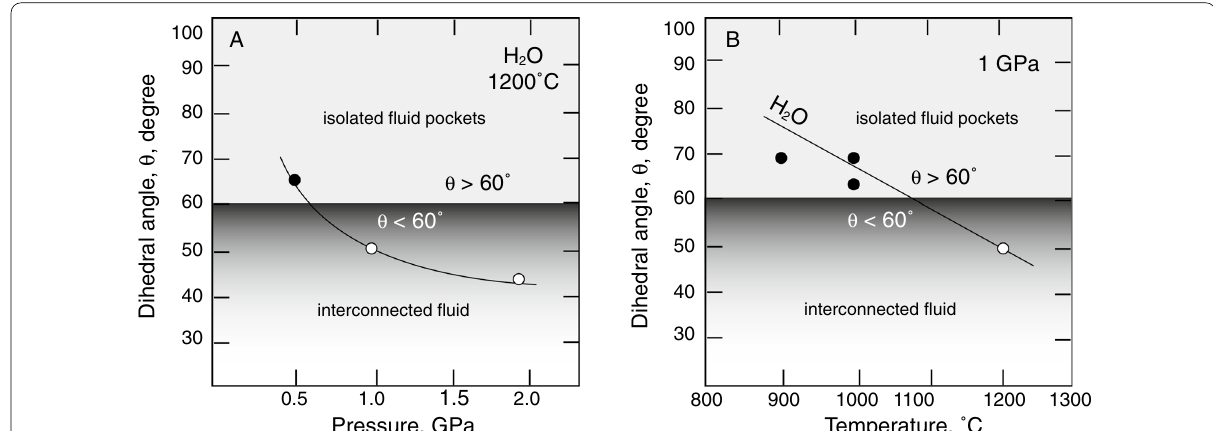
Fig. 35 A . Dihedral angle in dunite–H 2 O at 1200 °C as a function of pressure. B . Dihedral angle in dunite–H 2 O as a function of temperature at 1 GPa. Modified from Watson et al. (1990)